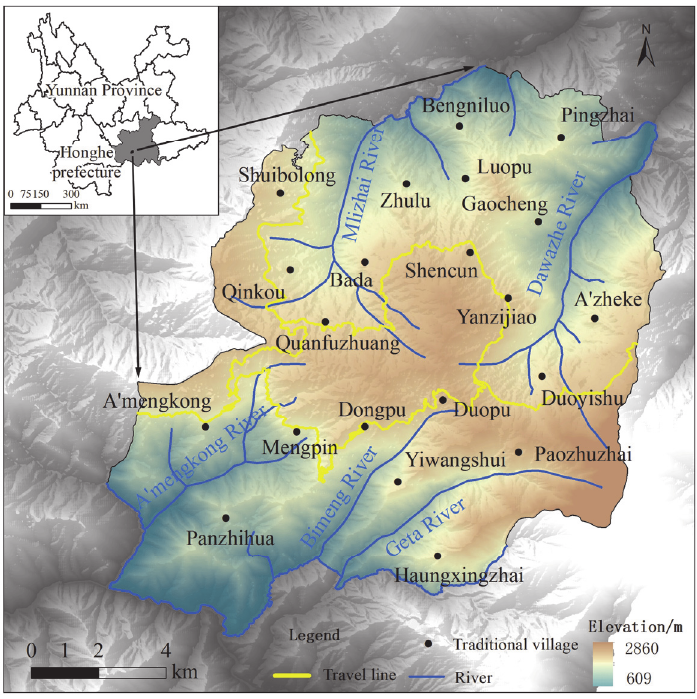
Figure 2. The location of the HHRT World Cultural Heritage site and the villages in the core area.